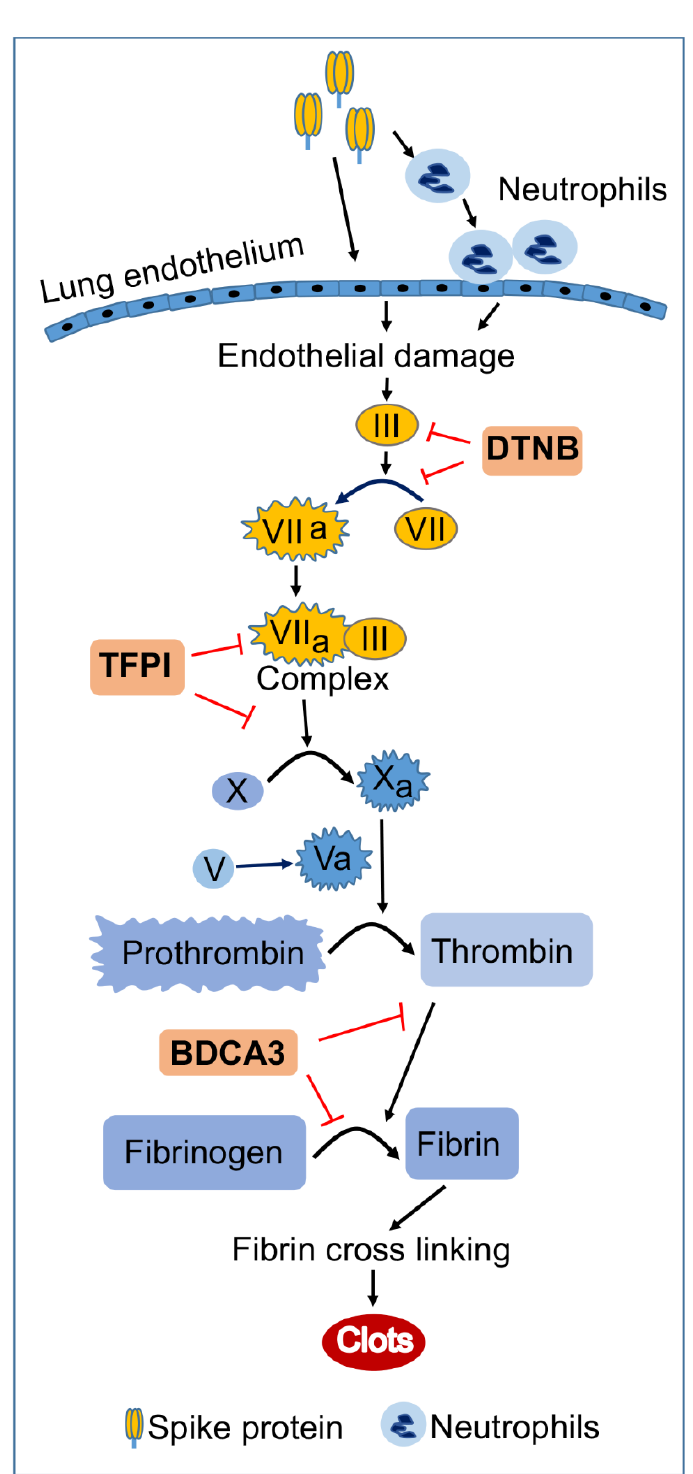
Figure 10. Model illustrating the coagulation cascade pathway in S-protein-induced TF, Factor-V, thrombin, and fibrinogen. Arrows indicate direct activation. The red ⊥ symbol indicate pharma- cological inhibitors. Yellow boxes indicate factors associated with the extrinsic pathway of blood coagulation. Blue boxes indicate factors associated with the common pathway of blood